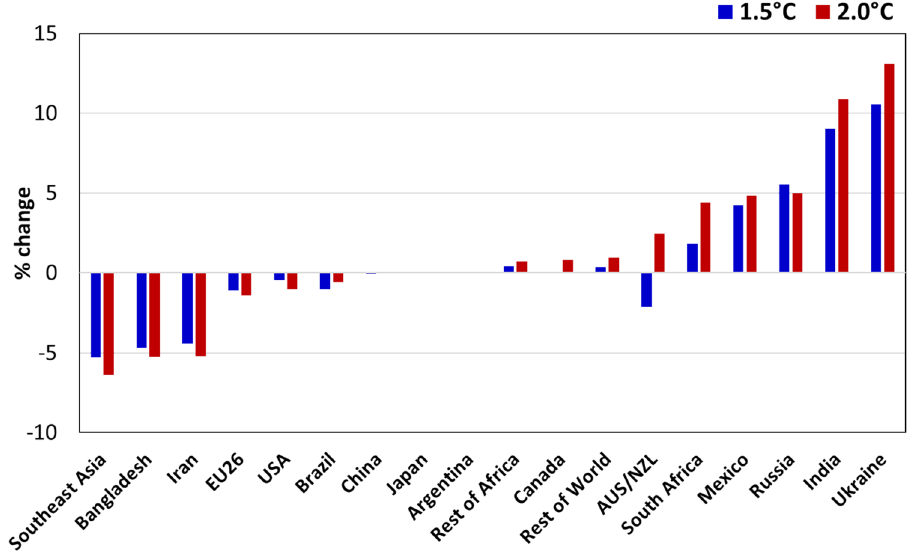
Figure 8. Changes in Self-sufficiency ratio of maize in main countries under global warming by 1.5 °C and 2.0